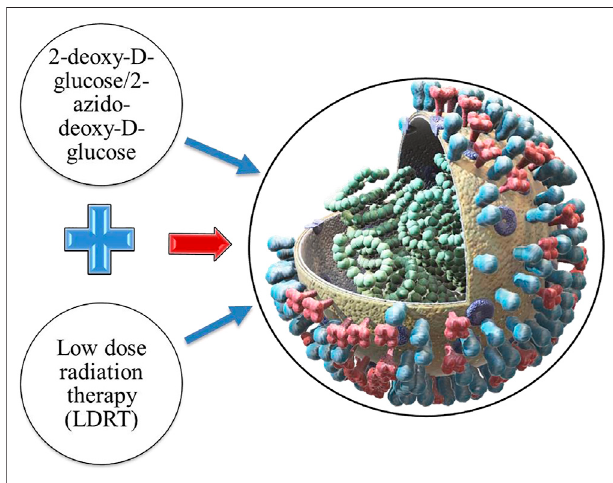
FIGURE 7 | 2-DG/2Azido-2-DG based radiation therapy in SARS-CoV- 2